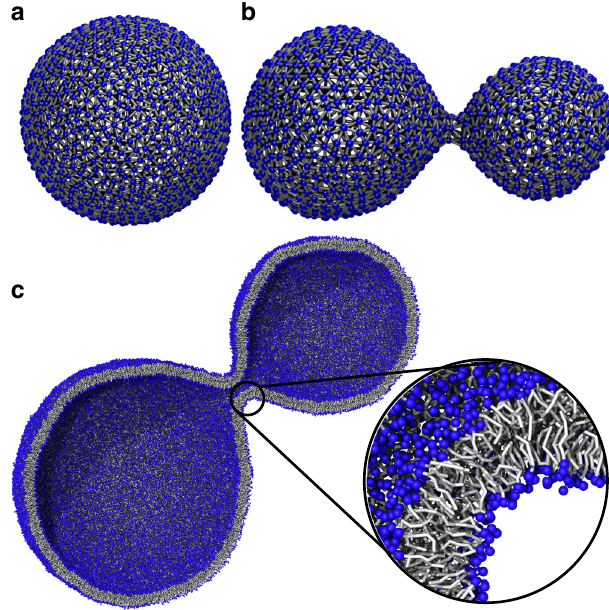
Fig. 3 Backmapping of a growing vesicle. a Original vesicle con fi guration in the DTS model. b Equilibrated vesicle structure after performing DTS simulation. c Backmapped vesicle to the Dry Martini model after 200 ns CG-MD simulation. Blue beads are phosphate group of the DOPC lipids, gray bonds represent the lipid